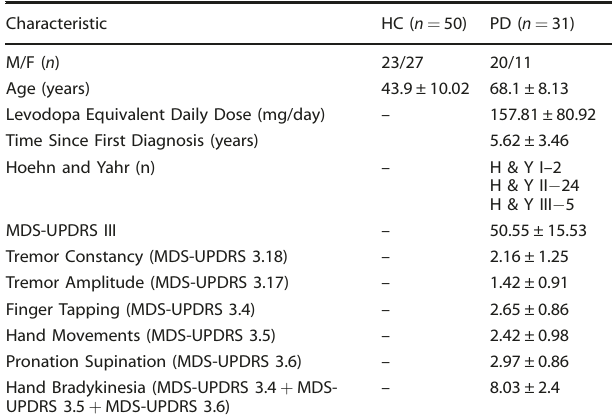
Table 2. Characteristics of subjects used for